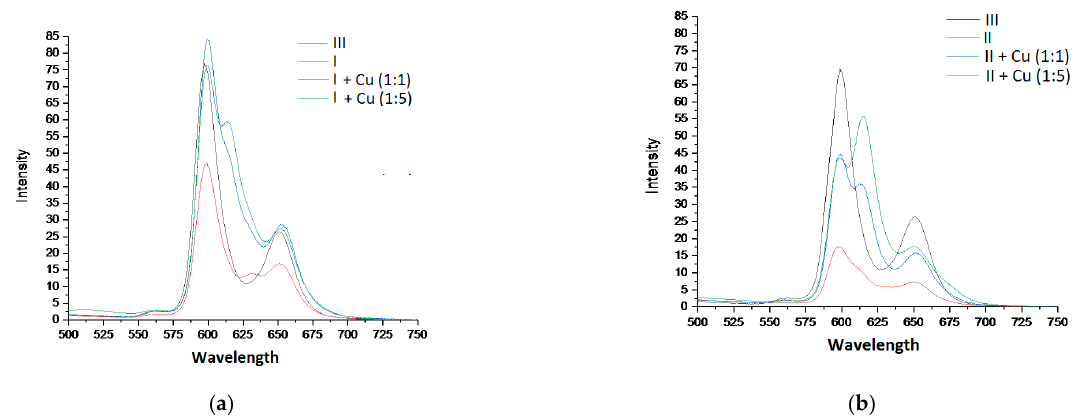
Figure 12. Fluorescence spectra of the studied systems with different concentration ratios of the reagents, λ ex = 416 nm (I-( a ), II-( b )).